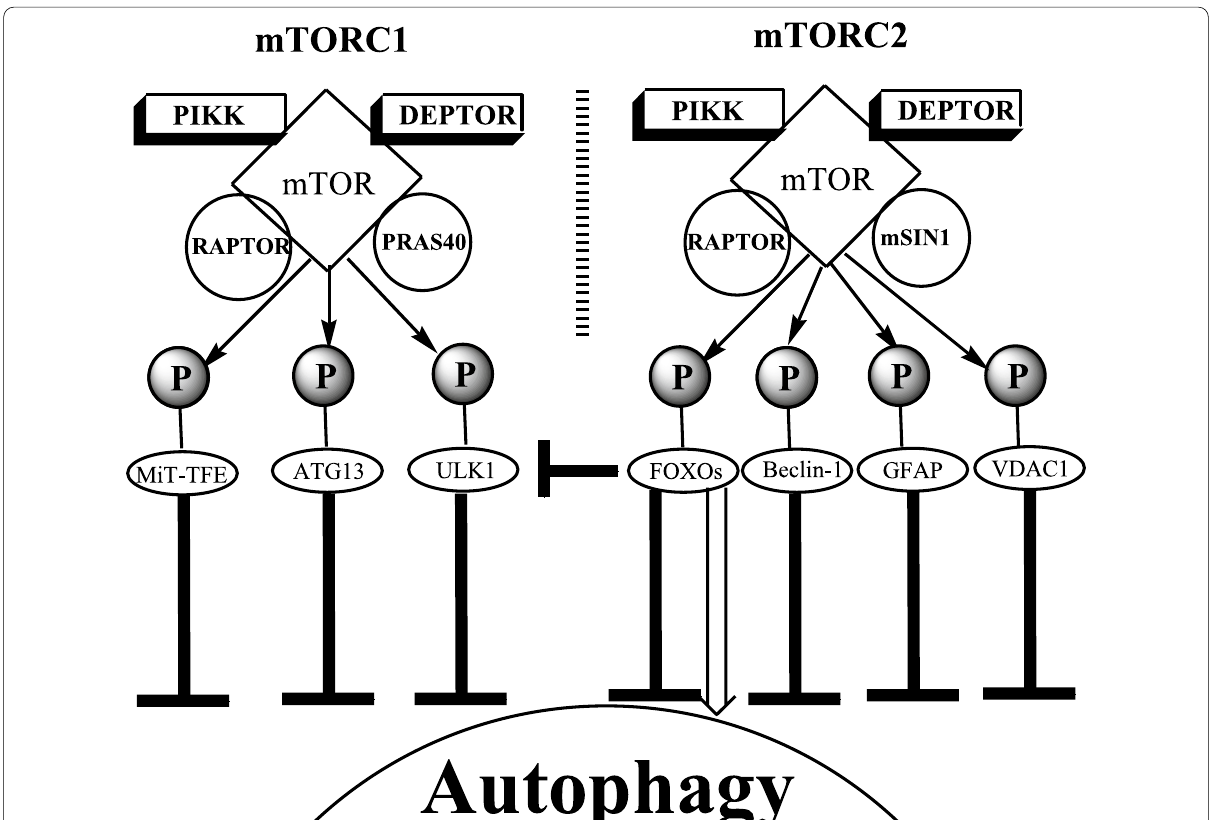
Fig. 4 The two different mTORC1/2 complexes and how autophagy is regulated by them. DEPTOR and PIKK are components shared by mTOR complexes, whereas PRAS40 and RAPTOR are special to mTORC1 and RICTOR and mSIN1 are limited to mTORC2. When mTORC1 phosphorylates the MiT-TFE factors, ATG13 and ULK1, autophagy cannot be positively regulated. Subsequently, Beclin-1, GFAP, and VDAC1 are phosphorylated by mTORC2 to prevent them from also inducing autophagy. The subcellular location of FOXO proteins is altered by mTORC2-mediated phosphorylation, which has a variety of effects on the control of